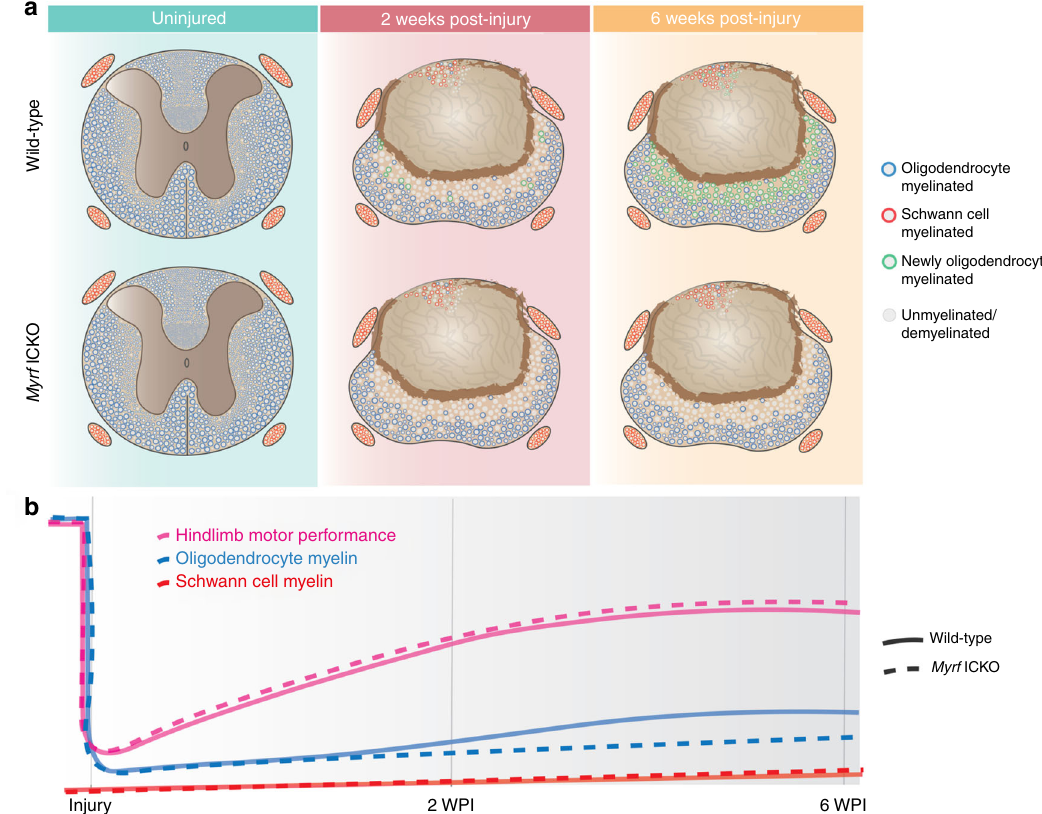
Fig. 7 New oligodendrocyte and Schwann cell myelination after SCI and its relationship to locomotor recovery. a Schematic of the uninjured and injured mouse spinal cord two and six WPI following moderate dorsal thoracic contusion. In the uninjured spinal cord, axons are myelinated solely by oligodendrocytes and peripheral nerves are myelinated by Schwann cells. By two WPI, the lesion epicenter is ringed by a glial scar and mostly devoid of axons. Demyelinated axons are seen in a gradient increasing outwards from the medial spinal cord. By six WPI, extensive oligodendrocyte remyelination is observed throughout the ventrolateral white matter in control mice with functional MYRF, but Myrf ICKO mice fail to produce new oligodendrocyte myelin. Schwann cell myelination is generally con fi ned to the dorsal column. The degree of Schwann cell myelination does not differ in the injured spinal cord between Myrf ICKO and control mice. b Diagram illustrating the relative amount and rate of open fi eld hindlimb motor performance compared to the extent of oligodendrocyte and Schwann cell myelin after injury in the spinal cord. After thoracic SCI, there is a decline in both hindlimb motor performance and number of myelinated axons in the CNS. The majority of recovery of hindlimb locomotor function on open fi eld testing occurs within the fi rst two weeks in both Myrf ICKO and controls. In contrast, the vast majority oligodendrocyte remyelination does not occur until after two weeks postinjury. Therefore, the relative time course of oligodendrocyte remyelination is not associated with hindlimb motor recovery after SCI. In contrast, Schwann cell myelination occurs within the fi rst two weeks after SCI and occurs at a relatively steady rate. The height of the lines is approximately proportional to the extent of loss and subsequent recovery after